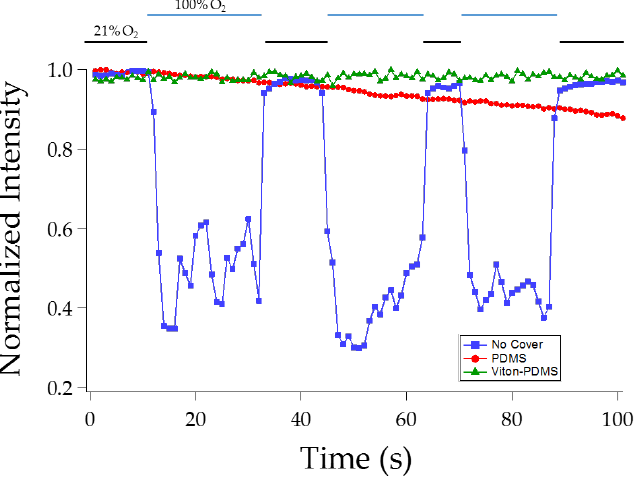
Figure 2. Normalized intensity (measured intensities divided by the corresponding maximum intensity) vs. time to summarize the effect of covering the chambers with 1. No Cover; 2. A PDMS slab; 3. A PDMS slab coated with Viton rubber. The microchamber was exposed to alternating normal air (21% O 2 ) and 100% O 2 gas. At each exposure outlined by the top two lines, multiple measurements were taken as indicated by the data points.